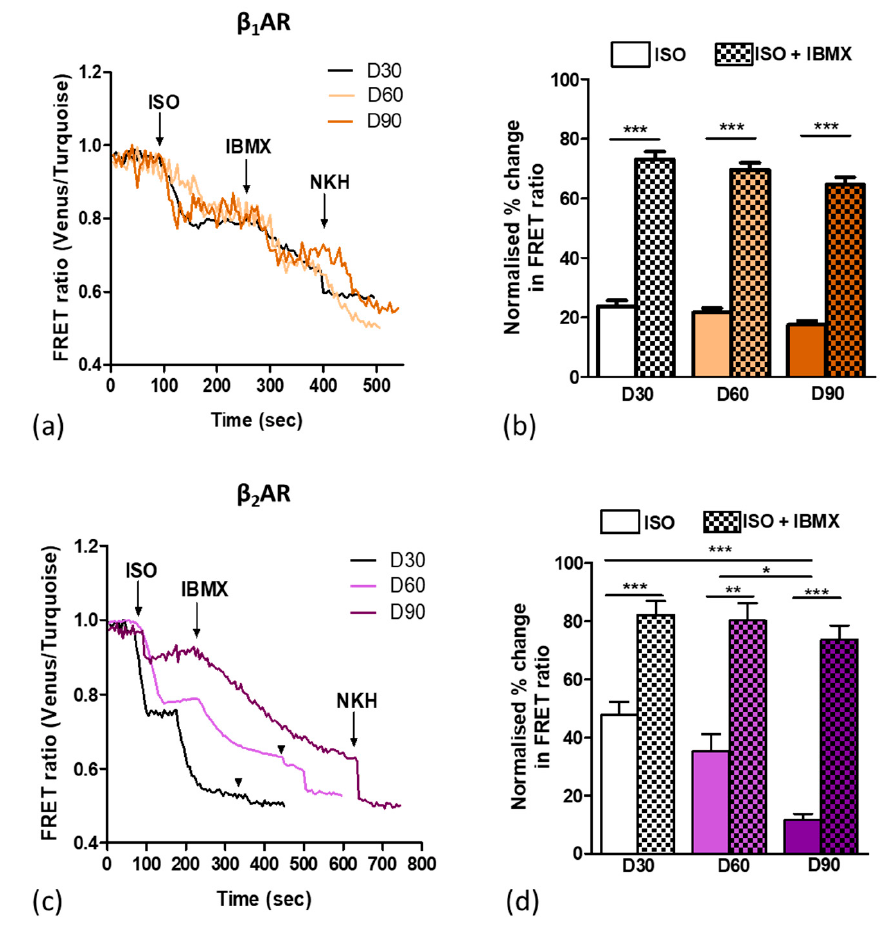
Figure 3. Time-dependent maturation leads to reduced cytosolic β 2 AR-dependent cAMP signals. ( a ) Representative FRET traces of D30, D60, and D90 iPSC-CMs upon β 1 AR stimulation with ISO in the presence of β 2 AR blocker, then the addition of IBMX for PDE inhibition and lastly the addition of NKH477 for the subsequent activation of AC. ( b ) Percentage change in the FRET ratio normalised to the maximal cAMP released by NKH stimulation D30 (n / N = 97 / 11), D60 (n / N = 158 / 11), and D90 (n / N = 121 / 8) for β 1 AR responses. ( c ) Representative FRET traces of D30, D60, and D90 iPSC-CMs upon β 2 AR stimulation with ISO in the presence of β 1 AR blocker, PDE inhibition with IBMX, and the subsequent activation of AC with NKH477. ( d ) Percentage change in the FRET ratio normalised to the maximal cAMP released by NKH477 stimulation at D30 (n / N = 38 / 4), D60 (n / N = 15 / 3), and D90 (n / N = 90 / 5) for β 2 AR responses. Data are presented as mean ± SEM. Significance was determined by one-way ANOVA with Bonferroni’s post-hoc test. * p < 0.05, ** p < 0.01, *** p < 0.001. n/N = cells/batches.